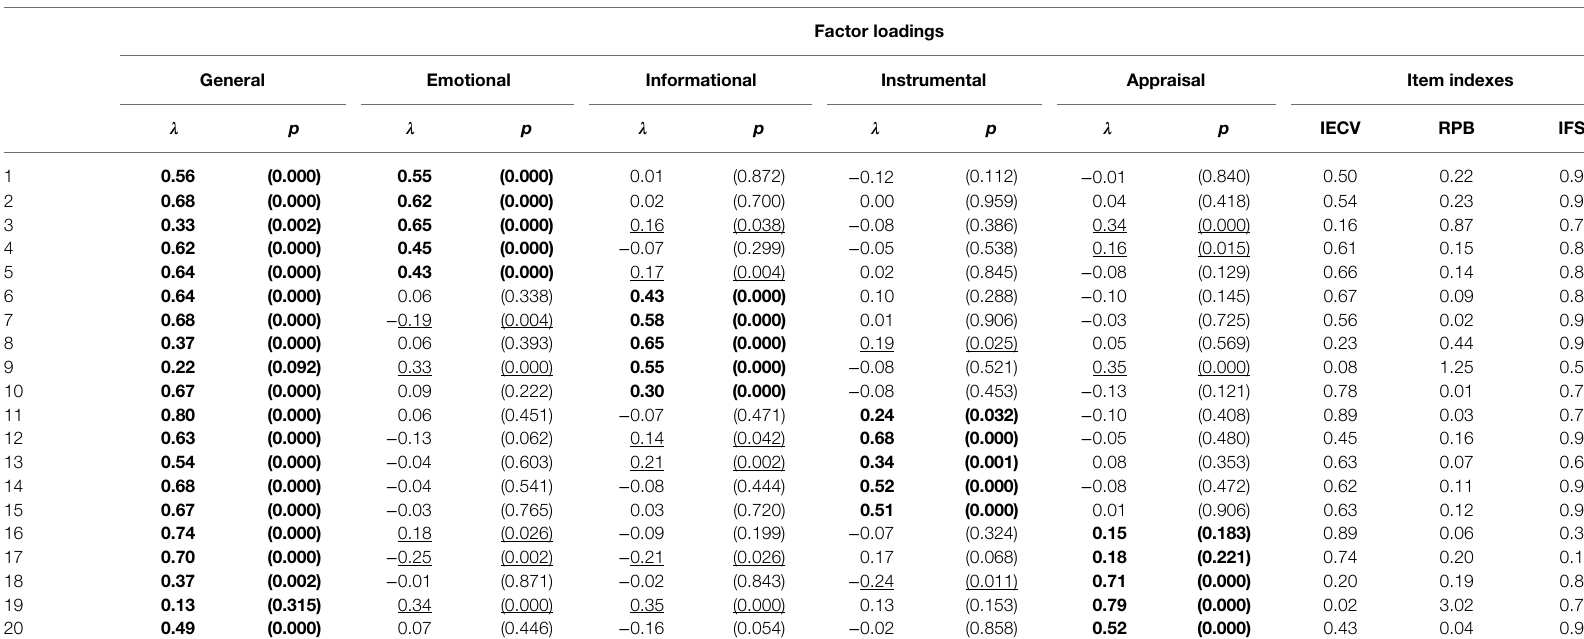
TABLE 4 | Standardized factor loadings and factor intercorrelations from the exploratory structural equation modeling bifactor solution of the HPSS. Factor loadings General Emotional Informational Instrumental Appraisal Item